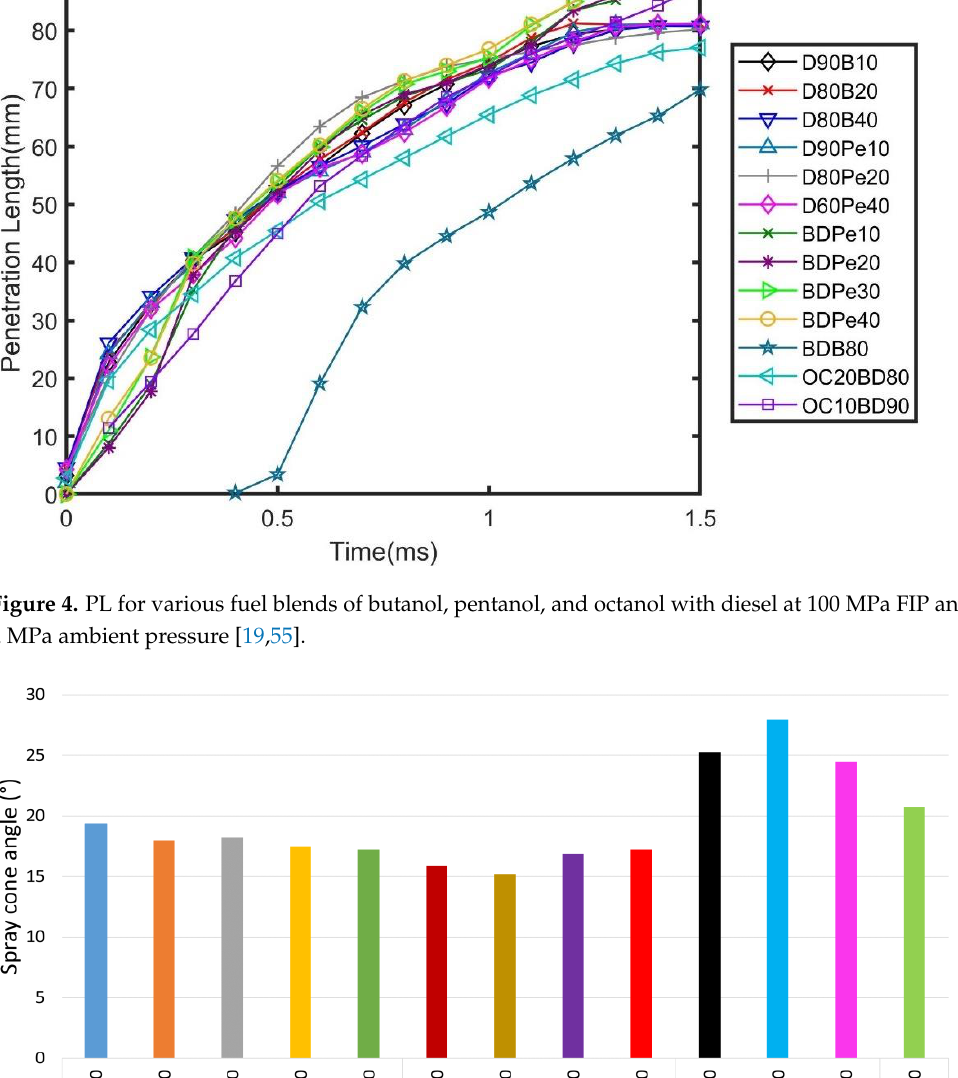
Figure 6. Maximum spray tip velocity for butanol, pentanol, and octanol with diesel at 100 MPa injection pressure and three different ambient pressures [19,51,55]. 2.6. Octanol Tian et al. [55] used four unique blends of octanol with diesel to investigate their spray properties. OC30BD70 fuel having 30% octanol showed the longest SPL, SPA; while the OC20BD80 fuel with 20% octanol had the largest spray cone angle. Hiroyasu and Arai model for predicting the fuel spray was also modified by including density, viscosity and the correction factor. The modified model was in good agreement for macroscopic prop- erties for high injection pressures. 2.7. Acetone-Butanol-Ethanol (ABE) Mixture The ABE mixture is a new potential additive as compared to other alcohols for fuels in IC engines [56]. Few authors have experimentally examined the impact of ABE on spray characteristics [57 – 59]. Algayyim et al. [58] studied the effect of ABE additive on macro- scopic spray characteristics of cottonseed biodiesel and diesel fuel at injection pressure of